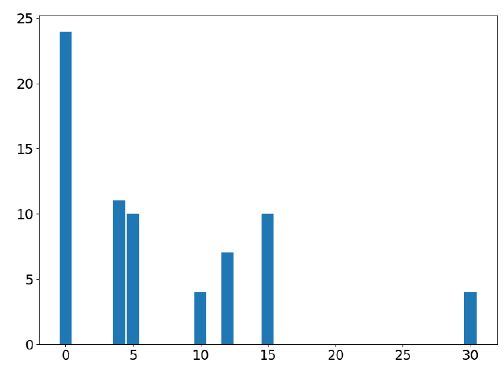
Figure 9 . # of n -generation models w.r.t. n H for search (III) with h 1 ; 1 = 3. The axes are the same as (cid:12)gure 7.